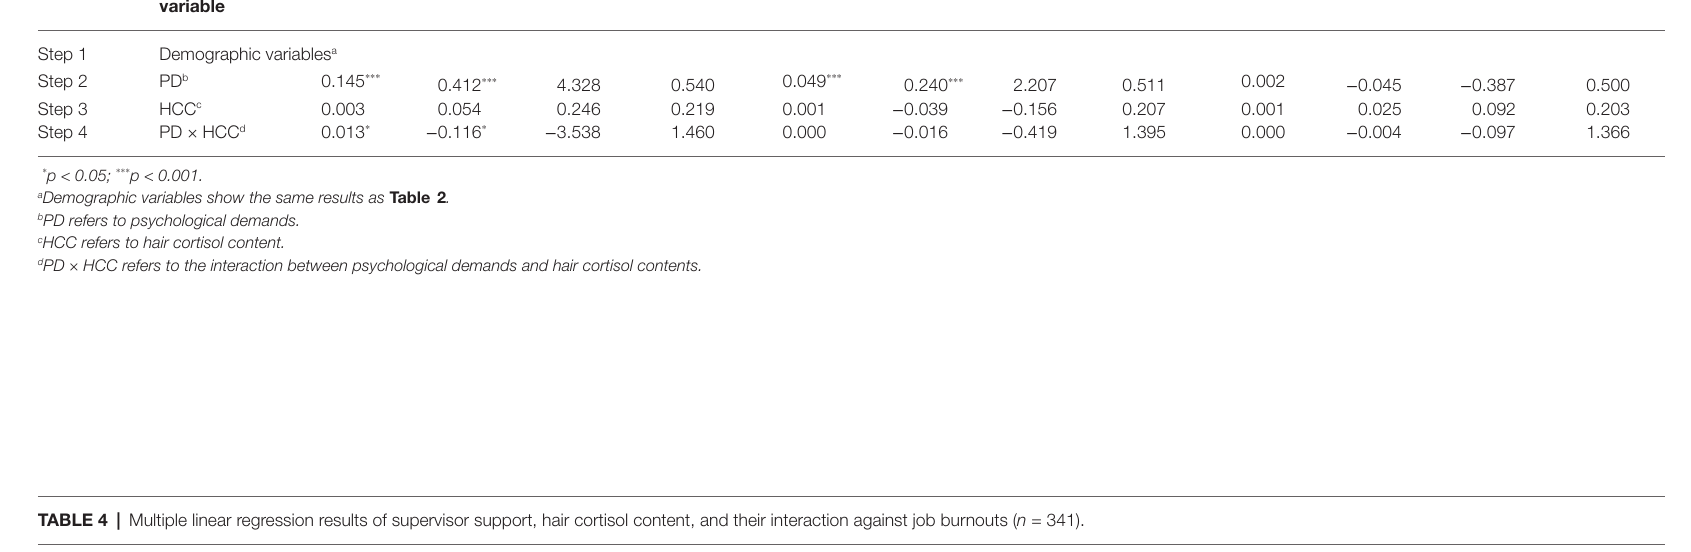
TABLE 4 | Multiple linear regression results of supervisor support, hair cortisol content, and their interaction against job burnouts ( n = 341). Independent Emotional variable